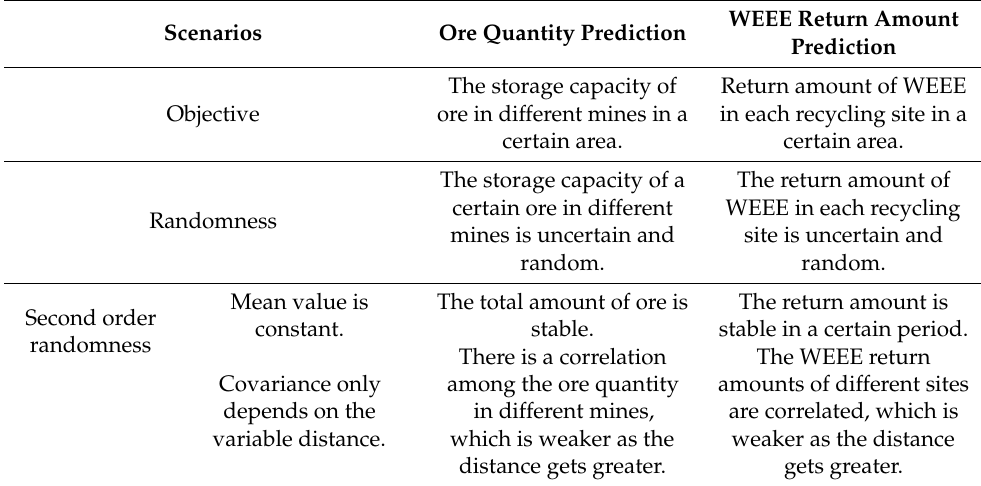
Table 1. Demonstration of WEEE return in accordance with the second-order randomness hypothesis.